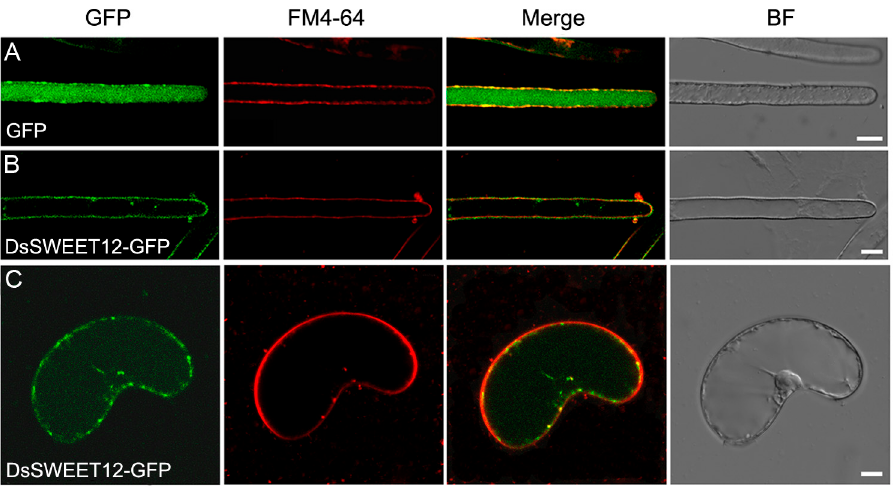
Figure 3. Colocalization of DsSWEET12-GFP with FM4-64 in Arabidopsis root hair cells and D. spiculifolius suspension cells. Arabidopsis root hairs stably expressing green fluorescent protein (GFP) ( A ) or DsSWEET12-GFP ( B ) and D. spiculifolius suspension cells transiently expressing DsSWEET12-GFP ( C ) were incubated for 1 min with 4 μ M FM4-64. GFP fluorescence is green, and FM4-64 is red. Merge is created by merging the GFP and FM4-64 fluorescence images. BF are bright field images. Scale bars = 10 μ m.